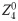
RMS spherical aberration (Z40) values of the designed IOLs for misalignment (left column) and tilt (right column) with each different cornea: A) Normal, B) Myopic, C) Hyperopic.